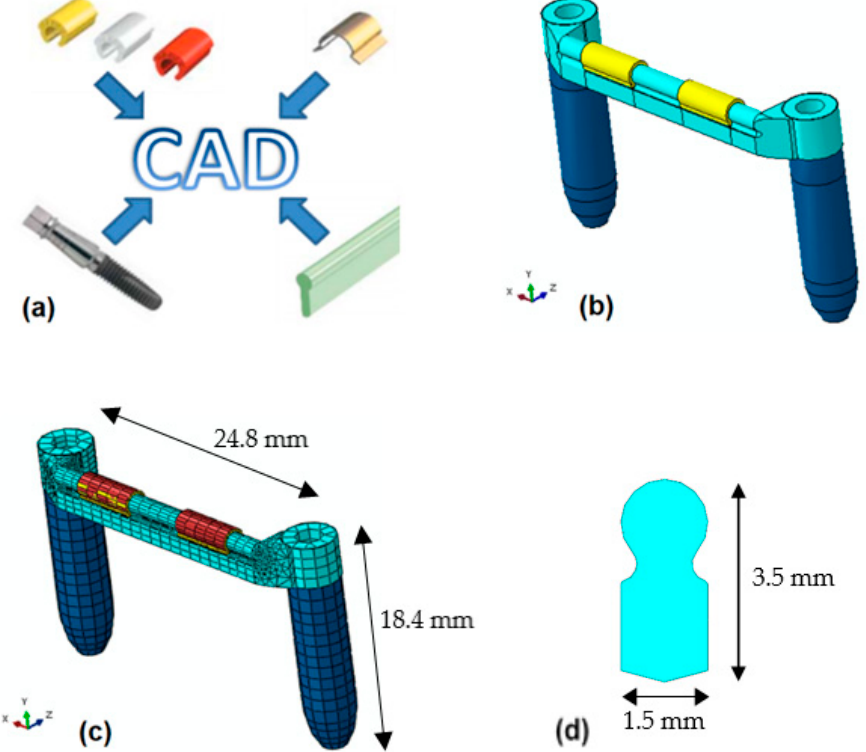
Figure 5. The geometry of the implant system: ( a ) assembly of clips, housing, bar, and implants; ( b ) computer-aided design model; ( c ) finite element mesh with main dimensions; and ( d ) bar cross section dimensions.